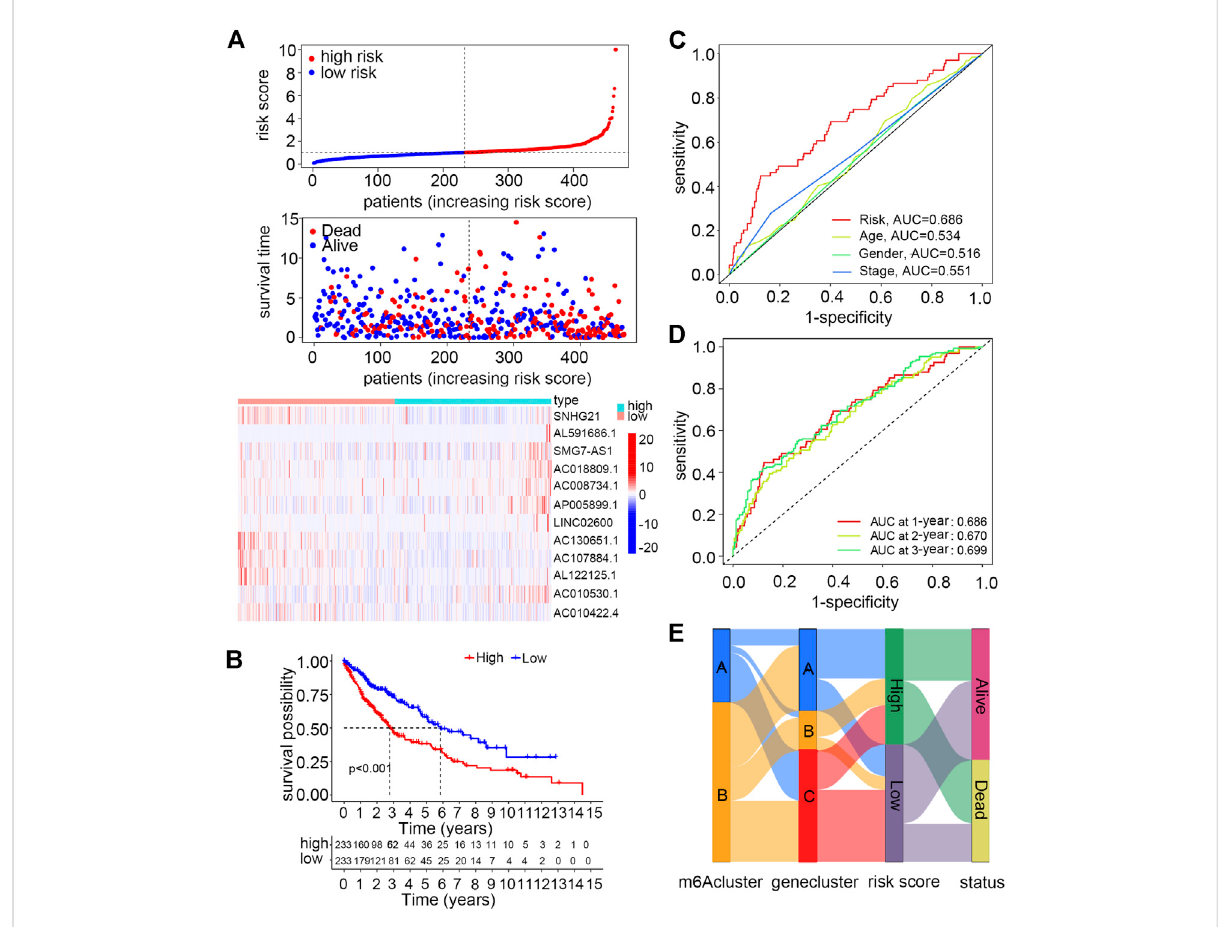
FIGURE 4 Construction and validation of a risk model using m6A-regulated immune-related lncRNAs for smoking-associated LUSC patients. (A) Distribution of the risk score and survival status and the expression levels of m6A-regulated immune-related lncRNAs between high- and low-risk groups. (B) Overall survival differences between high- and low-risk groups by Kaplan – Meier analysis. Log-rank p < 0.001 (C) ROC curves and AUC values of the risk score to compare the sensitivity and speci fi city of the risk score and other clinical features at 1 year. (D) ROC curves and